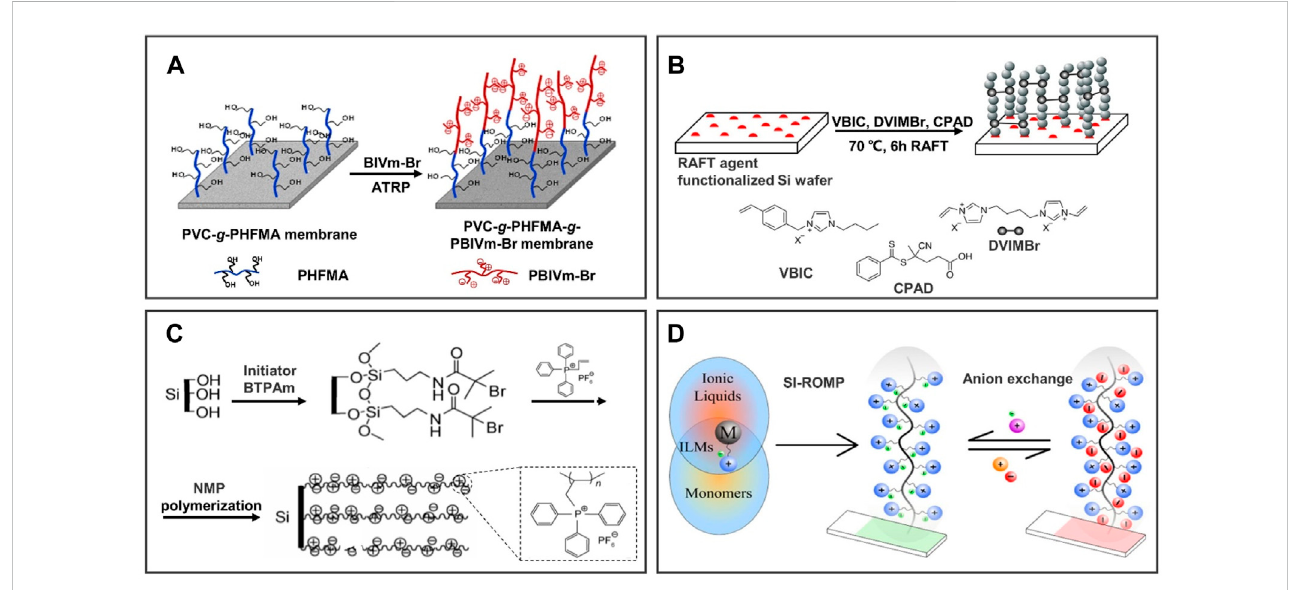
FIGURE 2 Preparation methods of 1D IL polymer brushes by chemical reaction. Numerous studies have reported on the preparation methods of ILs polymer brushes; four general preparation methods are introduced in brief as follows: (A) atom transfer radical polymerization (ATRP); (B) reversible addition- fragmentation chain transfer (RAFT); (C) ring-opening metathesis polymerization (ROMP); and (D) nitroxide-mediated radical polymerization (NMP). (A) reproduced with permission (Cheng et al., 2018). Copyright 2017, John Wiley and Sons, Ltd; (B) reproduced with permission (Demirci et al., 2020). Copyright2020,AmericanChemicalSociety; (C) reprintedwithpermission(Njorogeetal.,2017).Copyright2017,AmericanChemicalSociety; (D) reproduced with permission (Yang et al., 2010). Copyright 2010, Science China Press and Springer-Verlag Berlin